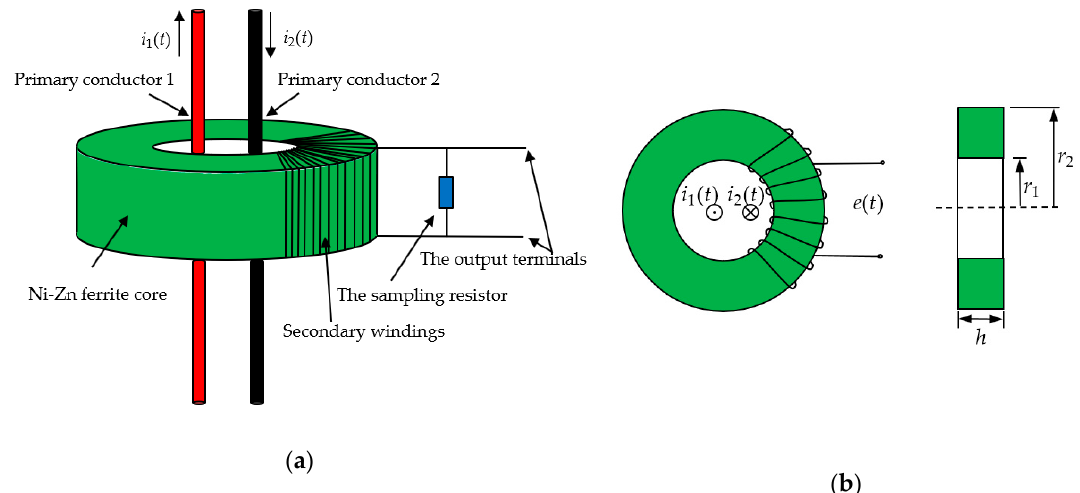
Figure 2. ( a ) Schematic diagram of a di ff erential high-frequency current transformer (D-HFCT) sensor; Figure 2 . ( a ) Schematic diagram of a differential high-frequency current transformer (D-HFCT) ( b ) dimensions of a D-HFCT sensor (without a sampling resistor). sensor; ( b ) dimensions of a D-HFCT sensor (without a sampling resistor).